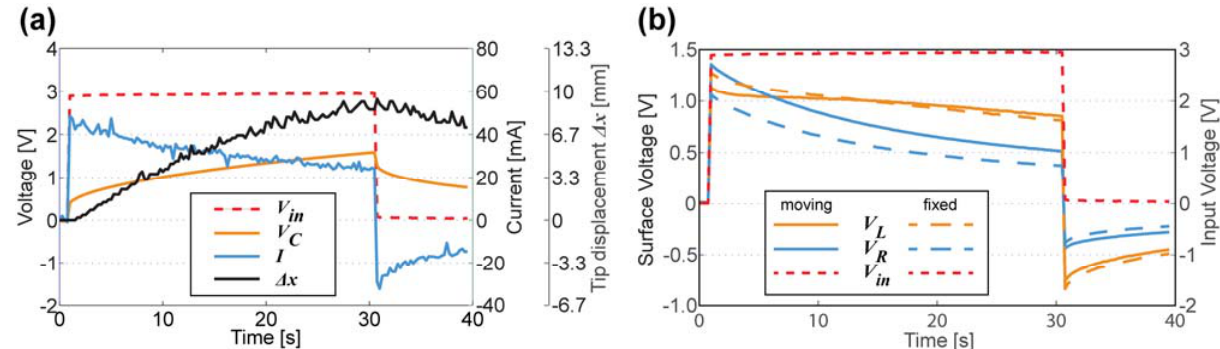
Figure 16. ( a ) Actuator driving signal V displacement along the horizontal axis Δ x ; ( b ) Voltage drops along the electrodes of the CPC actuator in unobstructed and fixed